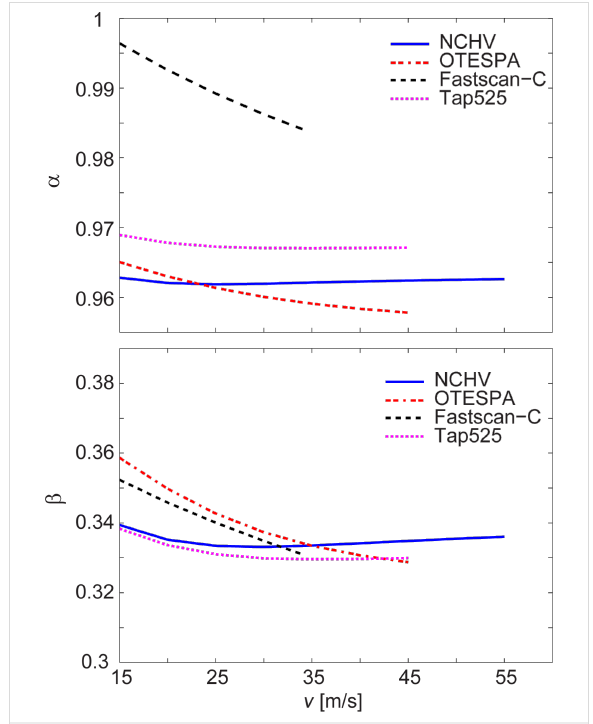
Figure 4: Fluid-flow-dependent conversion factors α and β for some of the cantilevers studied. The conversion factors of cantilevers RA2, RC2 and Tap150 (not shown) showed a behavior very similar to that of NCHV and